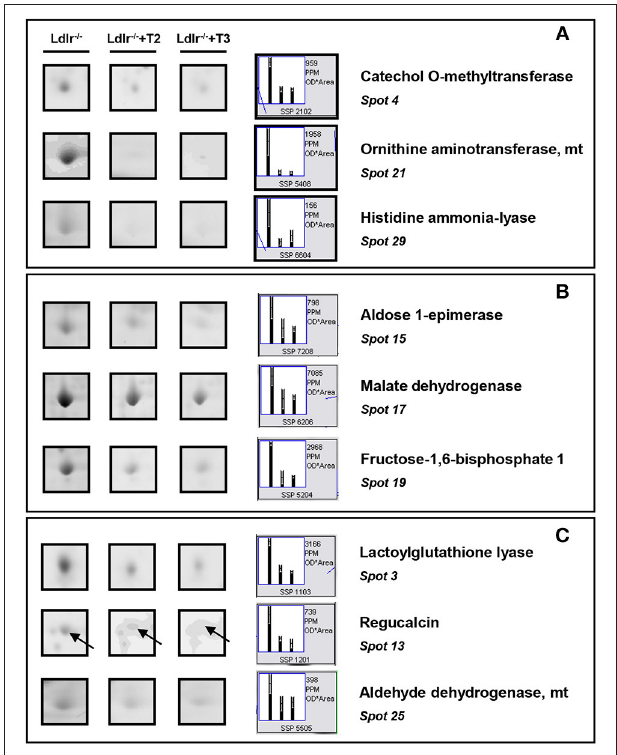
FIGURE 4 | T3- and T2-dependent differential expression in liver of Ldlr − / − mice: decreased proteins. Representative subsections of 2D-E images of livers of Ldlr − / − , Ldlr − / − + T2, and Ldlr − / − + T3 mice. (A) Enzymes involved in amino acid metabolism. (B) Enzymes involved in substrate metabolism. (C) Proteins involved in cellular stress. Results are expressed as arbitrary units (means ± SD; n = 4) ( p <